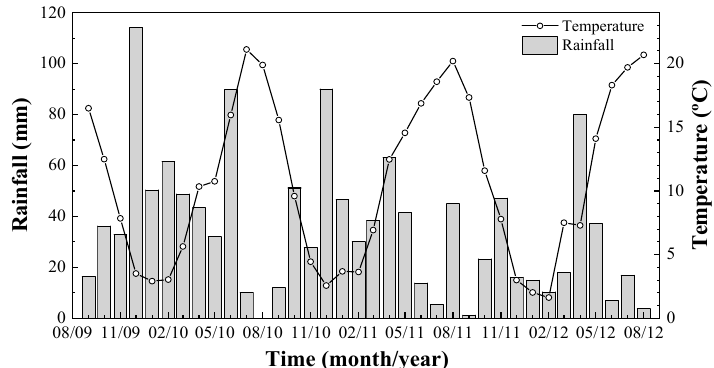
Figure 1 . Mean temperature and rainfall in the region under study over the three-year period (September 2009–August 2012).